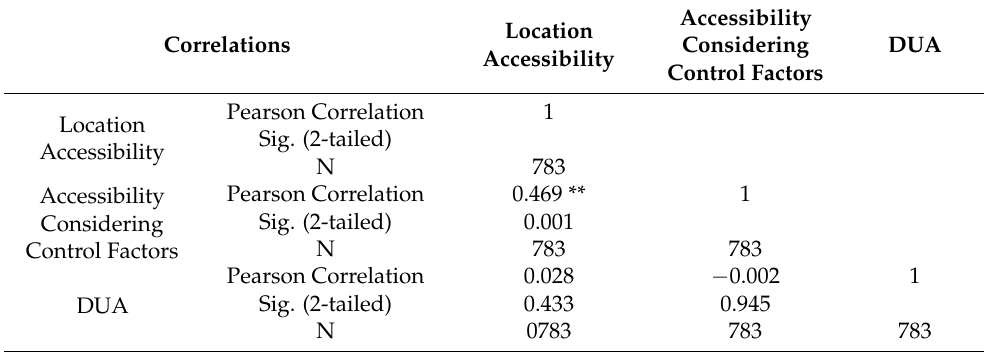
Table 5. The linear